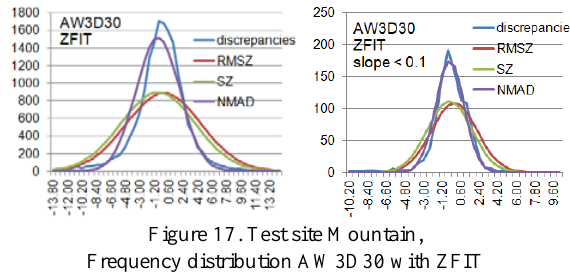
Figure 14. Accuracy results in test site Mountain